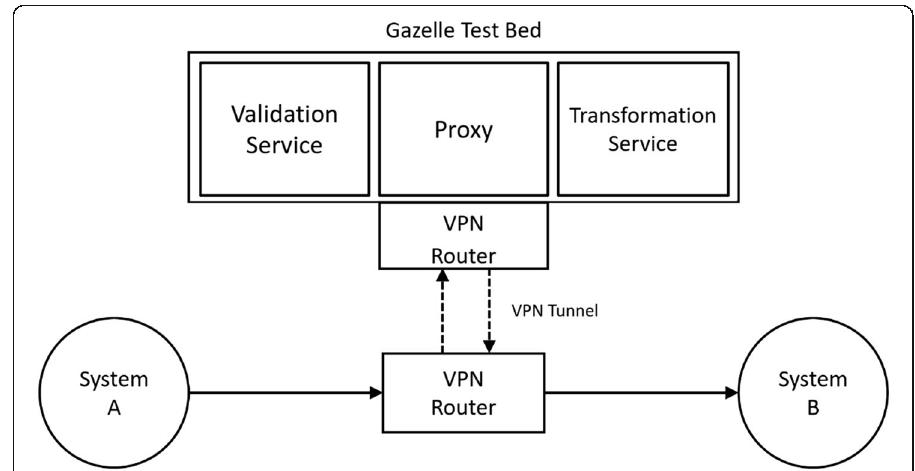
Fig. 4 Schematic set-up for interoperability testing between two systems. The one-directional communication via VPN connection is captured, transformed and validated by